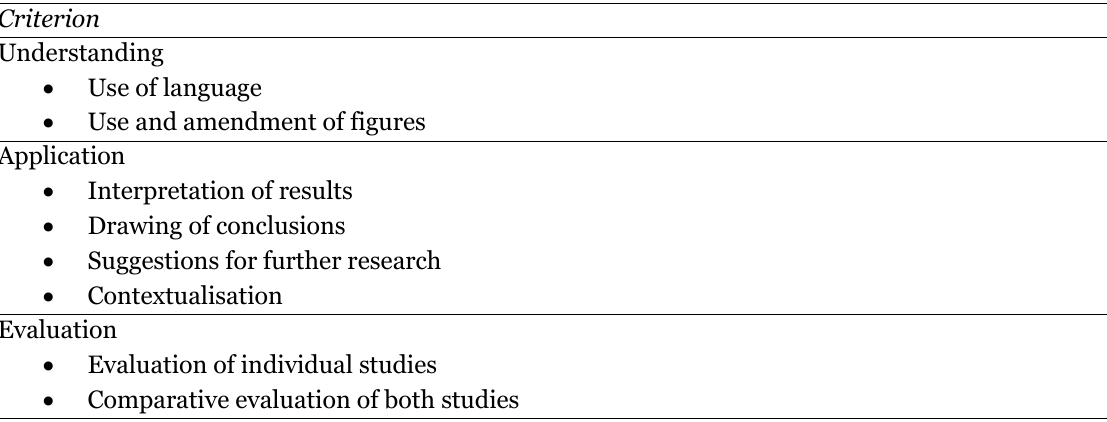
Table 1 Summary of Criteria Used to Assess Poster Content